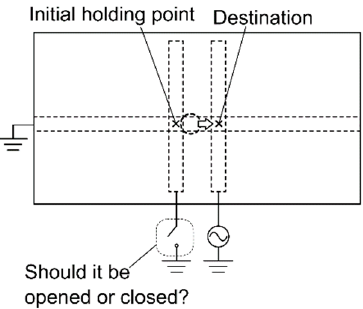
Figure 4. Options for transferring an object from one holding point to another.